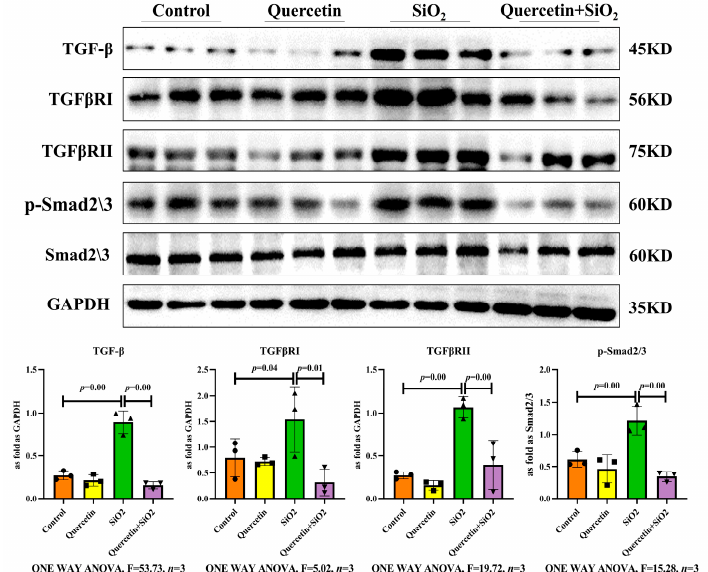
Figure 12. The expressions of TGF- β , TGF β RI, TGF β RII, and p-Smad 2/3 in the lungs, measured by Western blot. Data are presented as the mean ± SD, n = 3 per group.